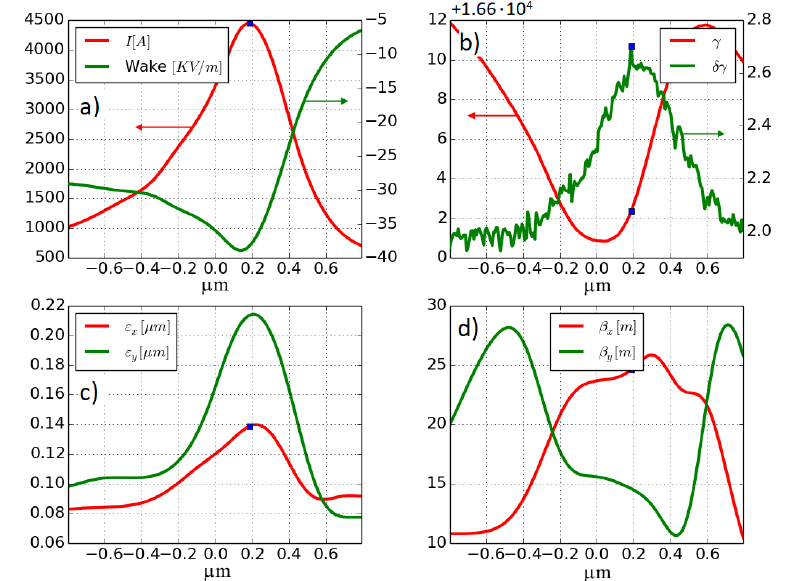
Figure 5. Nominal 20 pC electron beam at the entrance to the SASE3 undulator. ( a ) current profile (red) and resistive wakefields in the undulator (green); ( b ) energy (red) and energy spread (green) profiles of the electron bunch; ( c ) horizontal (red) and vertical (green) normalized emittance as a function of the position inside the bunch; ( d ) horizontal (red) and vertical (green) betatron function inside the bunch. The head of the bunch is on the